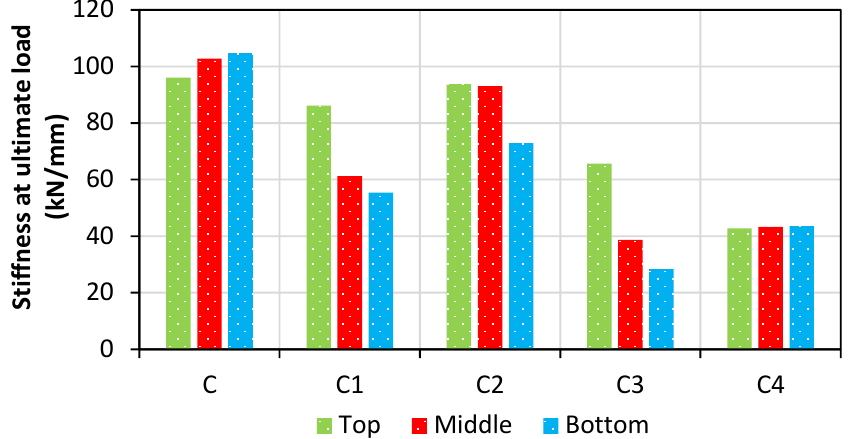
Figure 37. Stiffness of the specimens at the top, middle, and bottom regions.